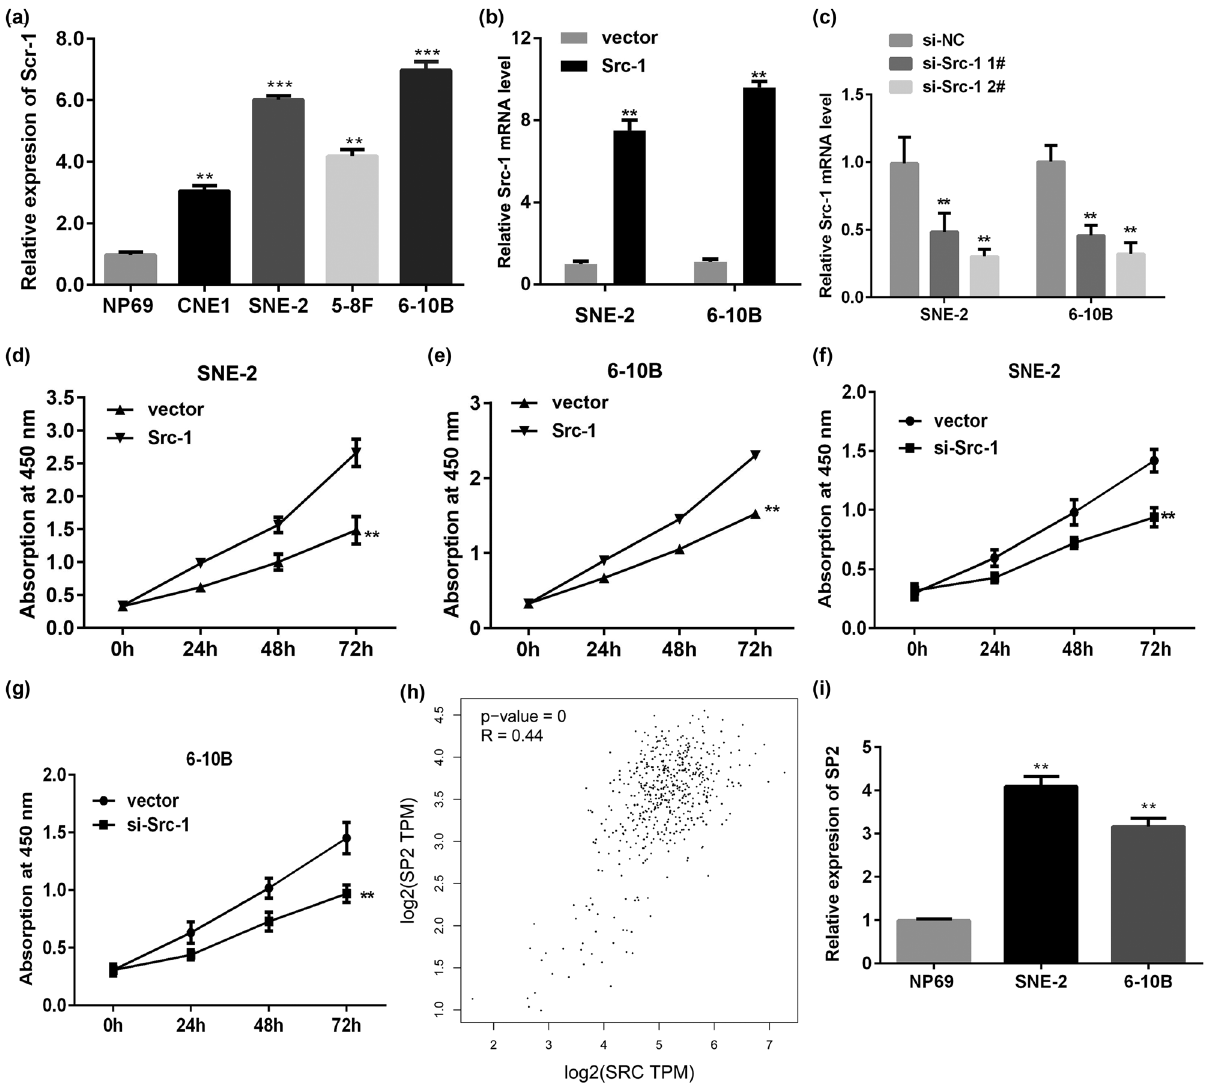
Figure 1: ( a ) The mRNA level was signi fi cantly increased in NPC cells, especially in SNE - 2 and 6 - 10B. ( b,c ) The transfection e ffi ciency was determined by qRT - PCR. ( d,e ) Overexpression of Src - 1 increased the cell viability of 6 - 10B. ( e ) Knockdown of Src - 1 suppressed the cell viability of SNE - 2. ( f,g ) Knockdown of Src - 1 suppressed the cell viability of SNE - 2. ( h ) EPIA analysis showed the expression of Src - 1 and SP2 was in positive correlation. ( i ) SP2 was upregulation in NPC cells. ** P < 0.01, *** P < 0.001 vs. NP69 or vector